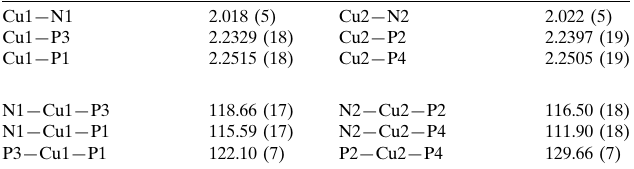
Selected geometric parameters (A˚ , (cid:2)